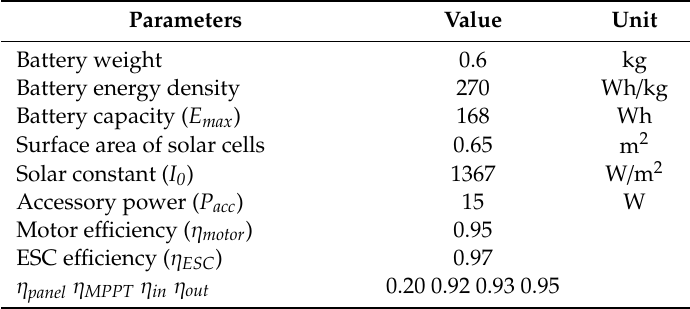
Table 2. Energy system parameters. ESC: electronic speed